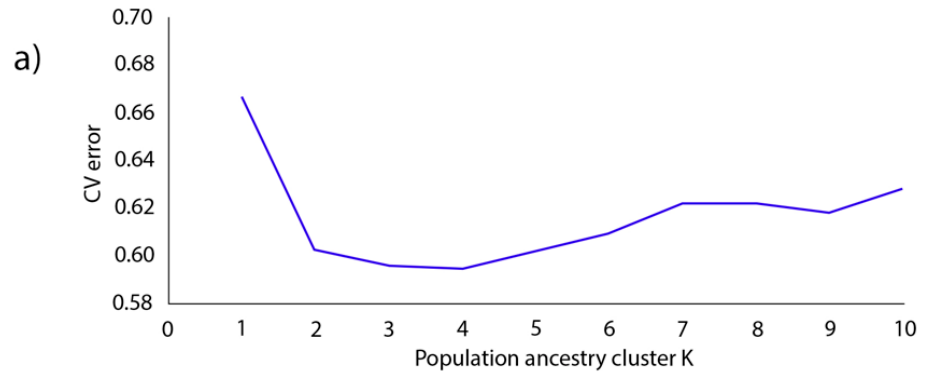
Figure 3. Admixture analysis results for all Ethiopian and non-Ethiopian cattle populations at K = 2 to 10. ( a ) Distribution of the coefficients of error variance and ( b ) ancestry proportions at K = 3 to